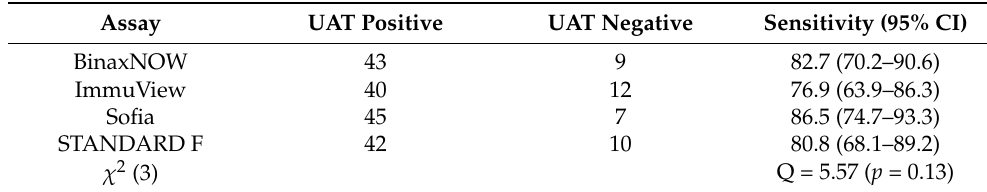
Table 2. Sensitivity of four Streptococcus pneumoniae urine antigen tests in patients with pneumo- Table 3. False negative and discordant test results by four Streptococcus pneumoniae urine antigen tests in 14 patients with coccal infection. pneumococcal